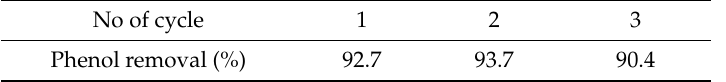
Table 5. E ff ect of repeated use on photocatalytic activity of ACF-EDP-30 composite